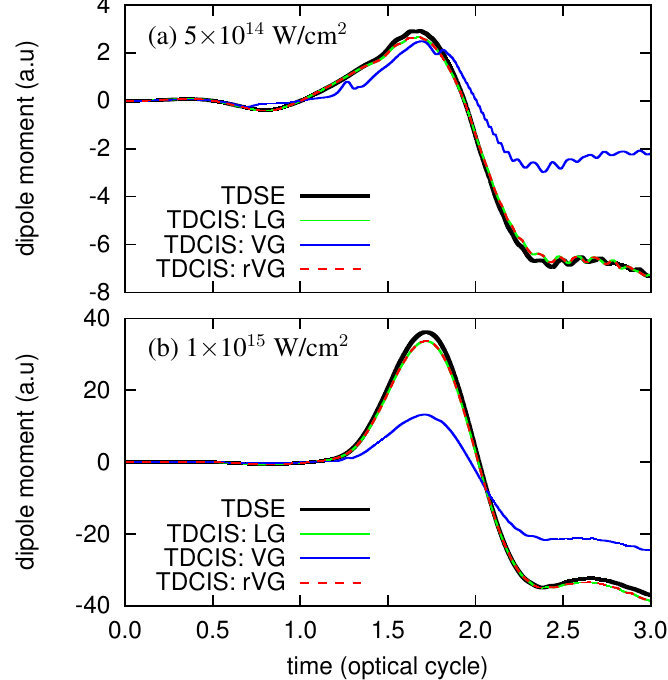
Figure 1. Time evolution of the dipole moment of 1D-He exposed to a laser pulse with a wavelength of 750 nm and an intensity of ( a ) 5 × 10 14 W/cm 2 and ( b ) 1 × 10 15 W/cm 2 . Comparison of the results with time-dependent configuration interaction singles (TDCIS) in the length gauge (LG), velocity gauge (VG), and rotated velocity-gauge (rVG) with that of the time-dependent Schrödinger equation